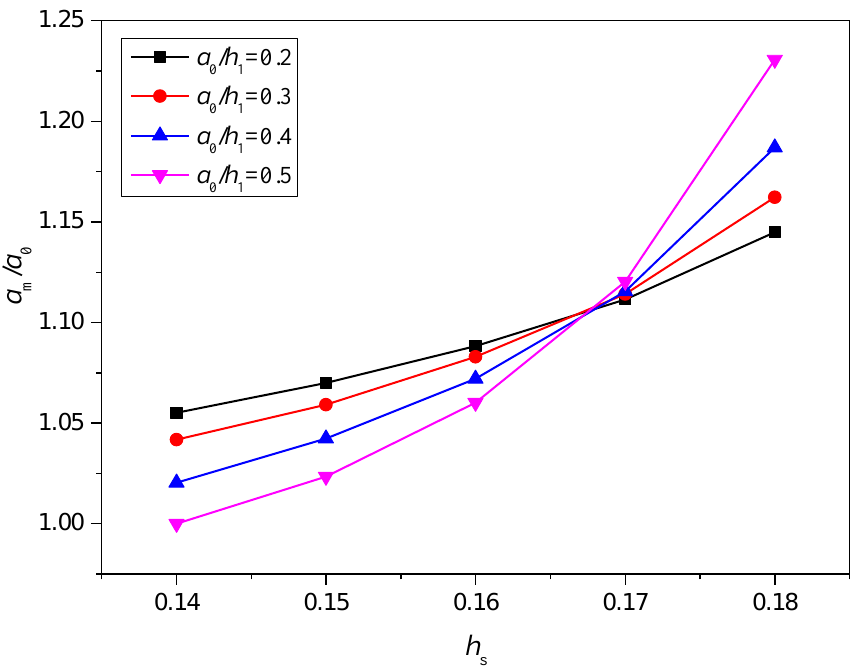
Figure 12. Variation in dimensionless maximum wave amplitude for different slope heights with initial dimensionless wave amplitude a 0 /h 1 = 0.2, 0.3, 0.4, and 0.5.